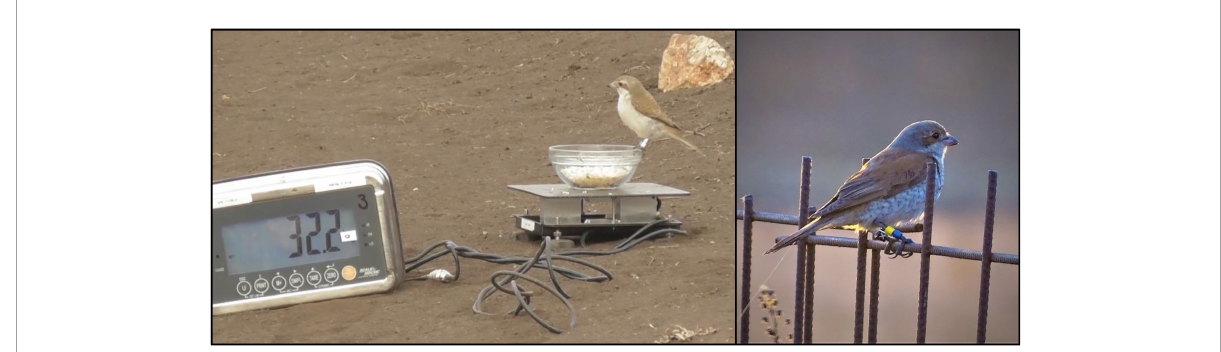
FIGURE1 Field measurement and observation of Red-backed Shrikes during stopover at the study area in the Hula Valley, Israel. (Left) A shrike perching on the feeding station, allowing the observer to record its body mass throughout its stopover period. (Right) Adult female shrike (ring number AB47045) with color rings allowing individual identification, as well as ATLAS transmitter (see the antenna of the transmitter near the tail of the bird) to record its movement during the stopover period and at departure from the